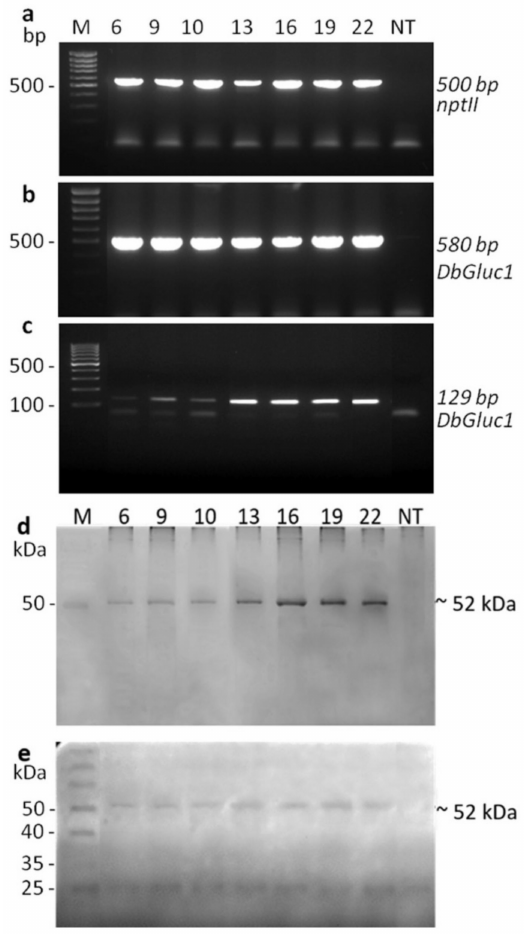
Figure 3. Analysis of transgene integration and expression by the PCR method ( a , b ); RT-PCR ( c ); the DbGluc1-HisTag detection technique ( d ) and SDS-PAGE detection of DbGluc1 activity ( e ). DbGluc1 ( a ) and neomycin phosphotransferase II ( b ) genes were detected in genomic DNA of transgenic plants with specific primers as PCR products of 580 and 500 bp, respectively. ( c ) RT-PCR analysis with primers designed within the DbGluc1 gene with the expected 129 bp length of the PCR product. ( d ) DbGluc1- His-tag protein expression examined using the InVision His-tag In-gel Stain detected as a single 52 kDa band with varying intensity in individual transformants. ( e ) Detection of β -1,3-glucanase activity on SDS-PAGE with laminarin following SDS